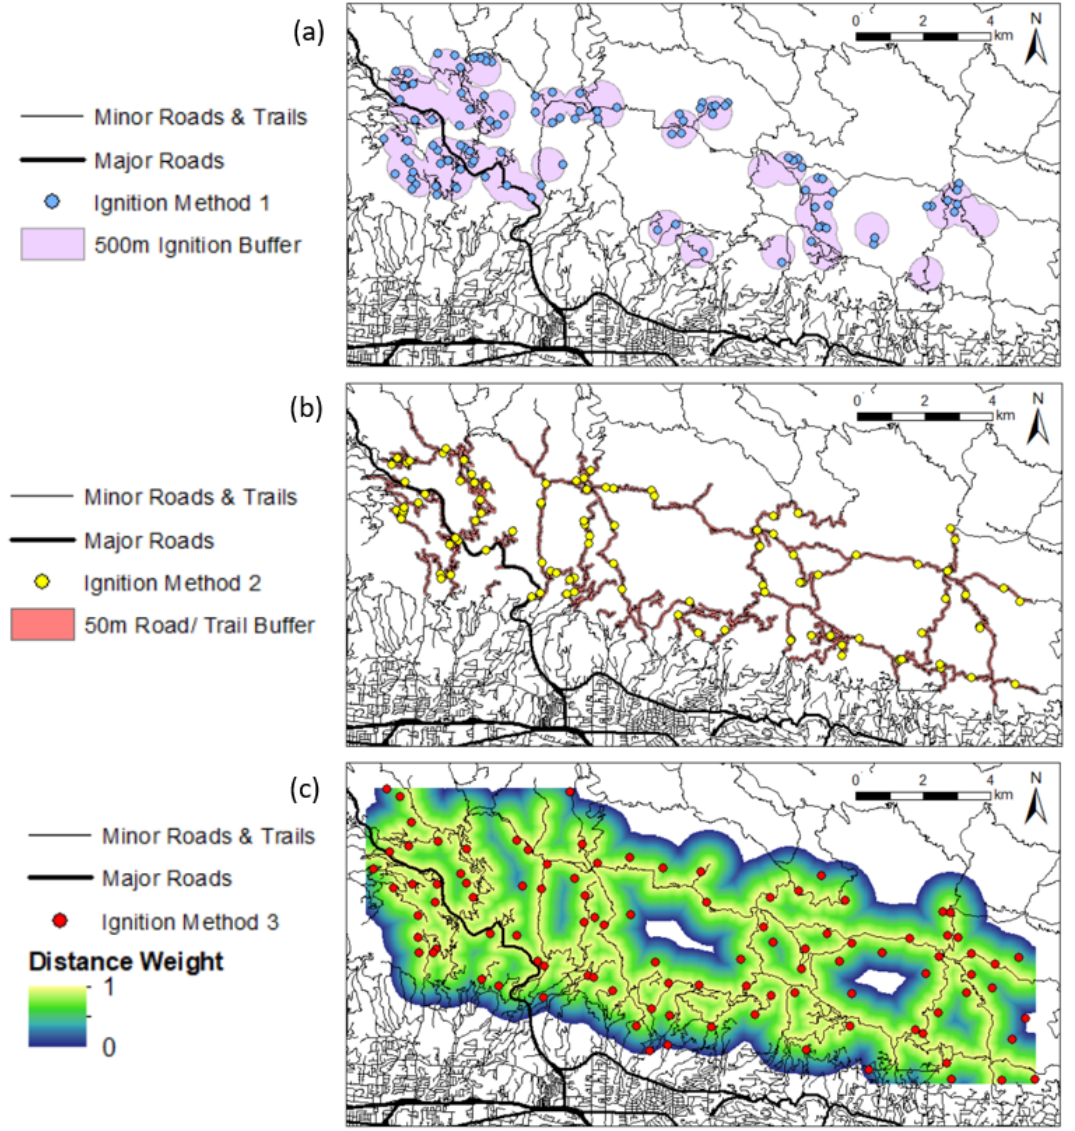
Figure 2. Results of the three ignition modeling methods overlaid on major (thick lines) and minor (thin lines) roads and trails. ( a ) Ignition modeling method 1: 500 m buffer (purple polygons) around previous ignition points with the modeled ignition points (blue dots). ( b ) Ignition modeling method 2: 50 m buffer (pink polygon) around roads and trails with the modeled ignition points (yellow dots). ( c ) Ignition modeling method 3: Distance–weight up to 1 km (colored) from roads and trails with modeled ignition points (red dots).